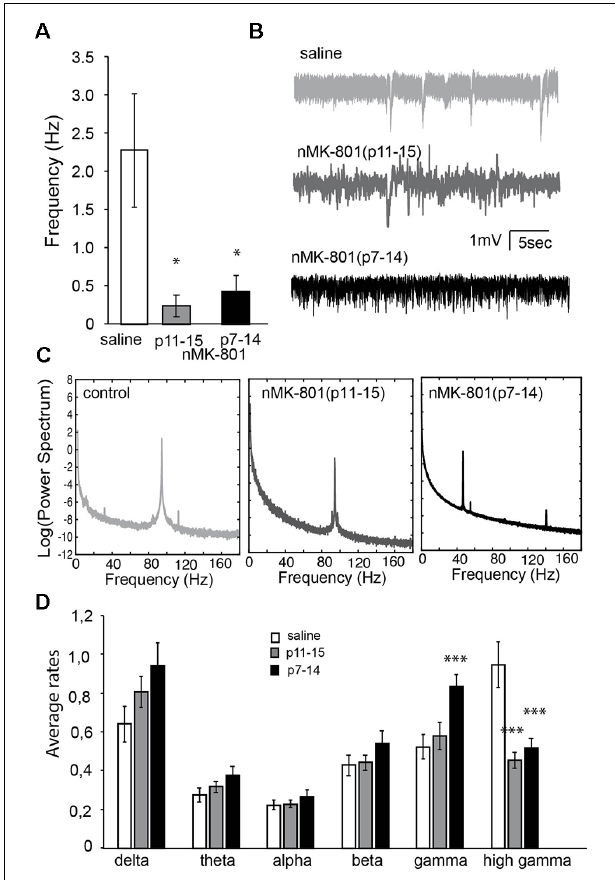
FIGURE 8 | Properties of spontaneous activity in the PFC of nMK-801(p7–14; n = 6 animals, 12 slices) and nMK-801(p11–15; n = 6 animals, 12 slices) compared to saline-treated controls ( n = 8 animals, 21 slices, pooled from both p7–14 and p11–15 groups). (A) Graph showing the frequency of up states is significantly different in nMK-801(p7–14) and nMK-801(p11–15)-treated mice compared to saline-treated (one-way ANOVA, F (2,28) = 3.911 p = 0.032). Post hoc analysis (LSD test) shows a significant decrease in both the nMK-801(p7–14; p = 0.03)